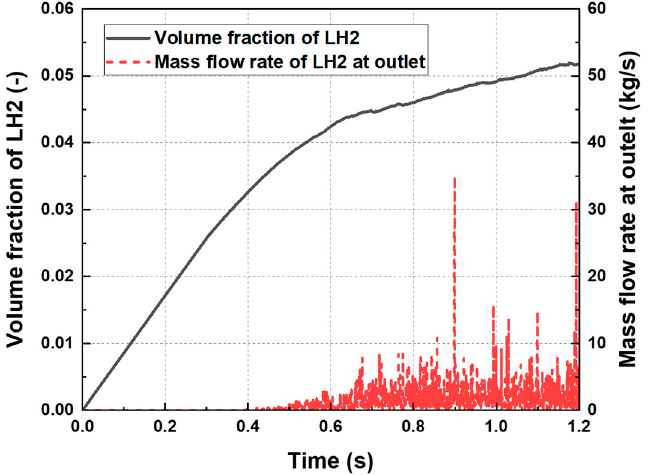
Figure 6. Variation in the volume fraction and mass flow rate at outlet of liquid hydrogen according to charging process.